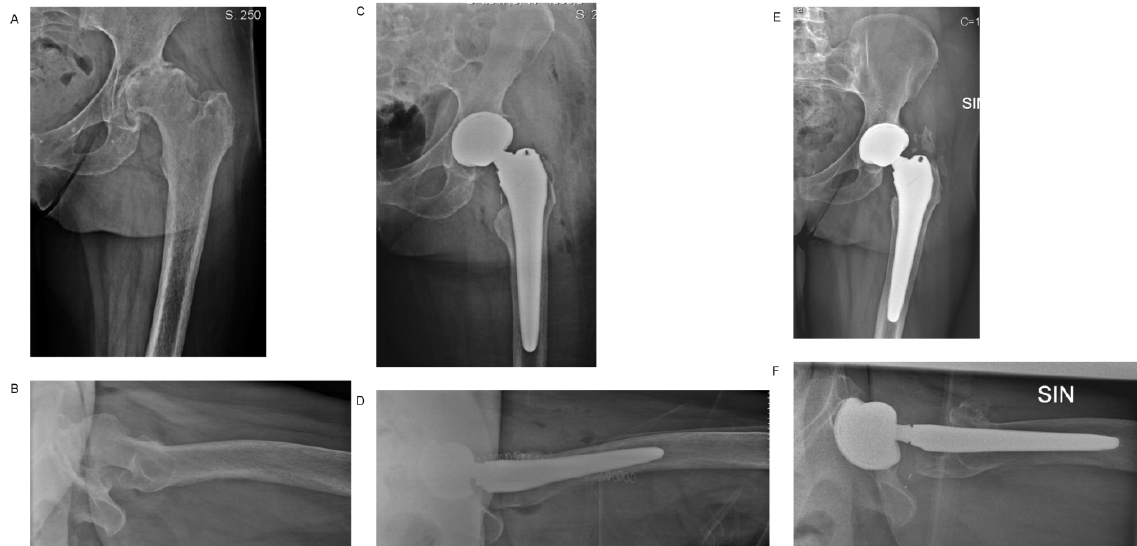
Figure 5. Female, 56 years old. Severe rheumatoid arthritis. Cementless total hip arthroplasty, coated with vancomycin 5% loaded DAC hydrogel. A and B. Pre-operative x-ray. Immediate (C and D) and (E and F) postoperative radiographic images at 18 months showing complete implant osteointegration at